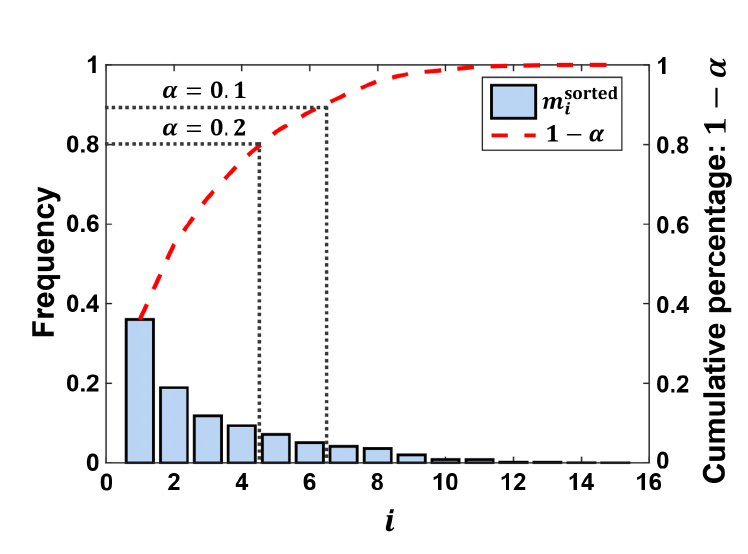
Figure 6. Pareto chart of parameter α and sorted histogram, M sorted